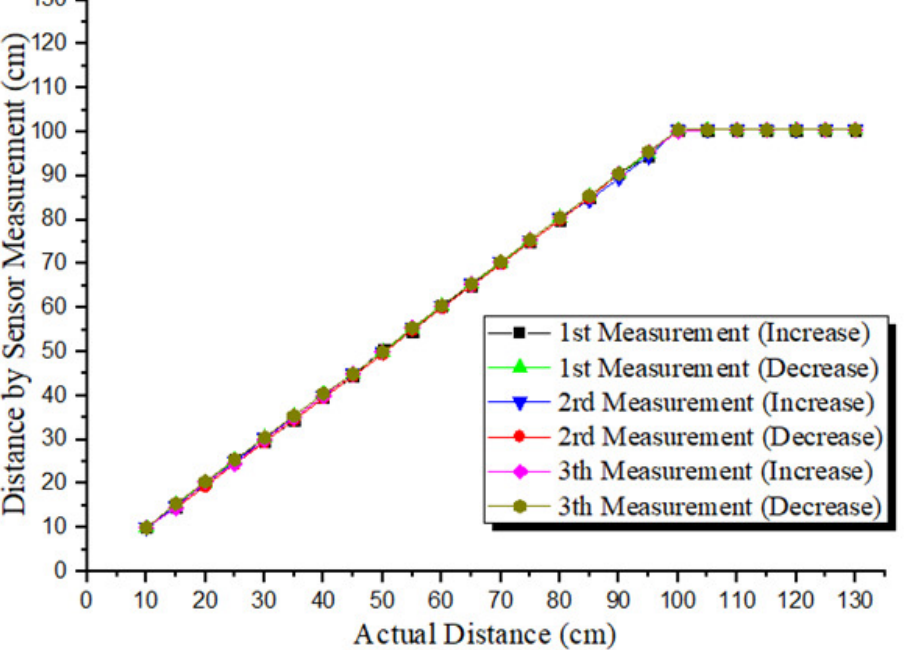
Figure 8. Graph of the Sharp IR GP2Y0A21 sensor’s working range shows that the sensor can read distances in the range of 10 cm to 100 cm. However, the sensor is saturated when reading the distance beginning from 100 cm and further, where the sensor cannot read the distance accurately.